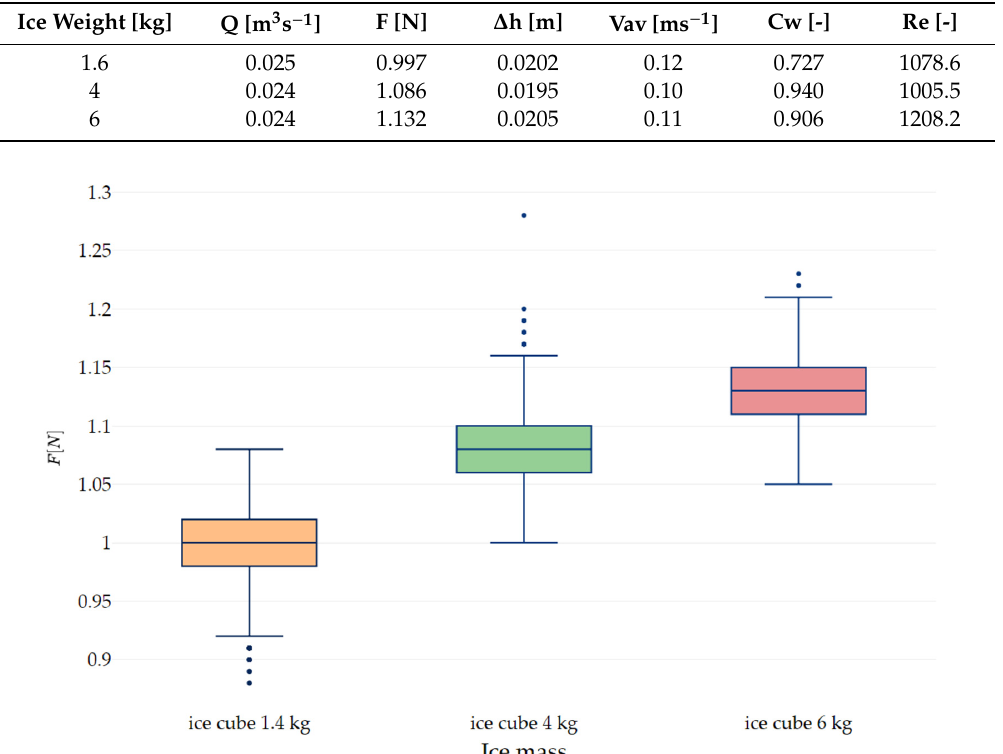
Figure 7. The distribution of drag force over the ice mass. The box represents the 25%–75% percentile with median marked, the whiskers are represented upper and lower fences (1.5× the inner quartile range). Dots represent outliers.